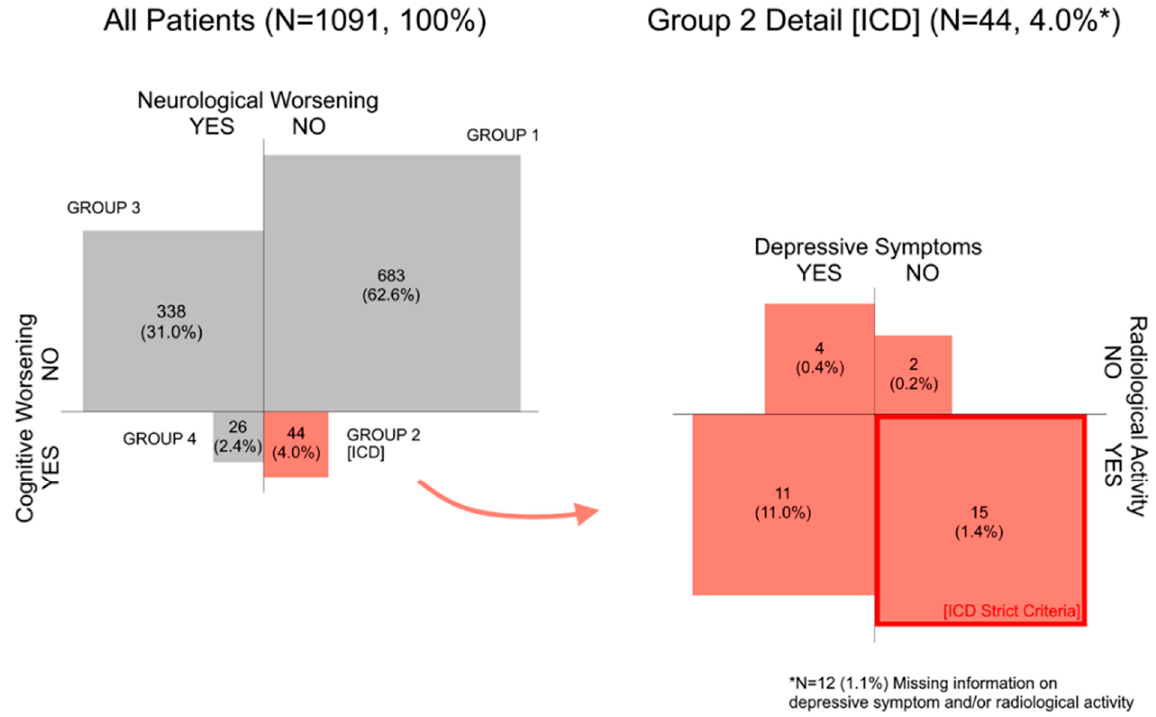
Figure 2. Neuropsychological and Neurological Evaluation between Baseline and Month 12.